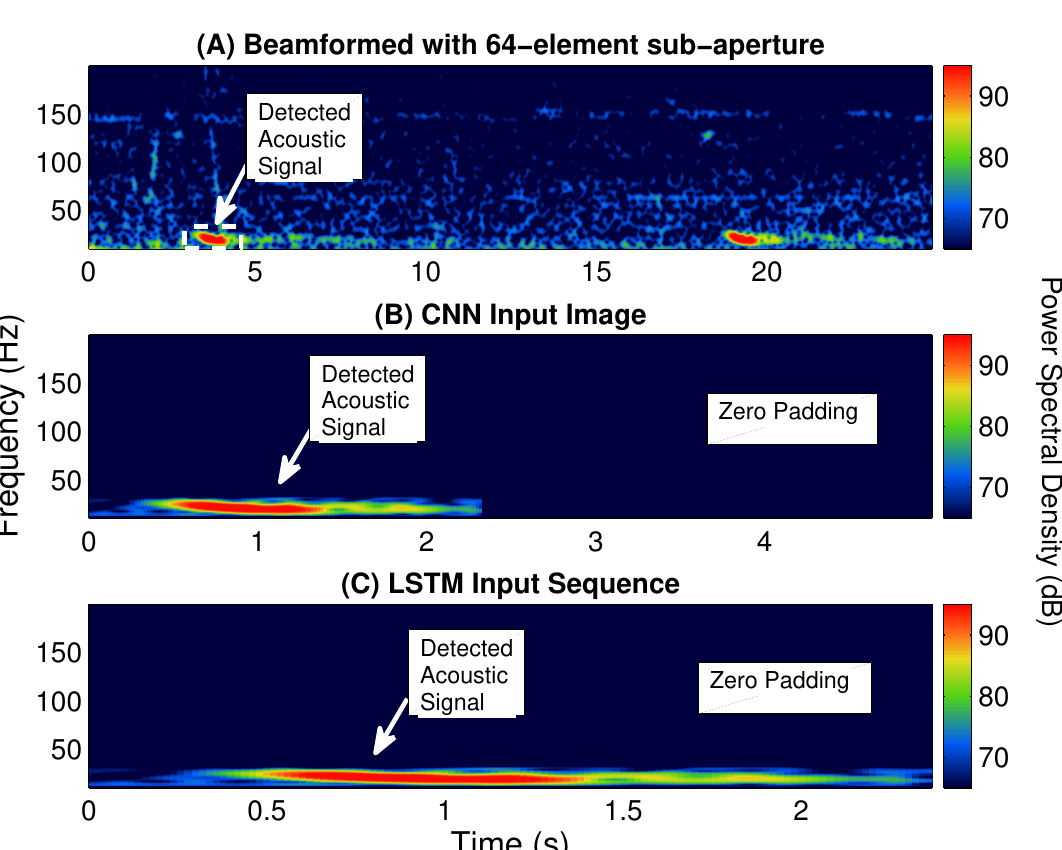
Figure 8. Plot ( A ) is an example of a beamformed spectrogram containing two fin whale 20 Hz pulses. Plot ( B ) and plot ( C ) are examples of a modified CNN input data image with zero padding and modified LSTM input data sequence with zero padding for the first 20 Hz pulse in plot ( A ). All the modified CNN images are defined to be 5 s in length due to hardware limitations, whereas the length of all the modified LSTM input data sequences are defined by the duration of each detected acoustic